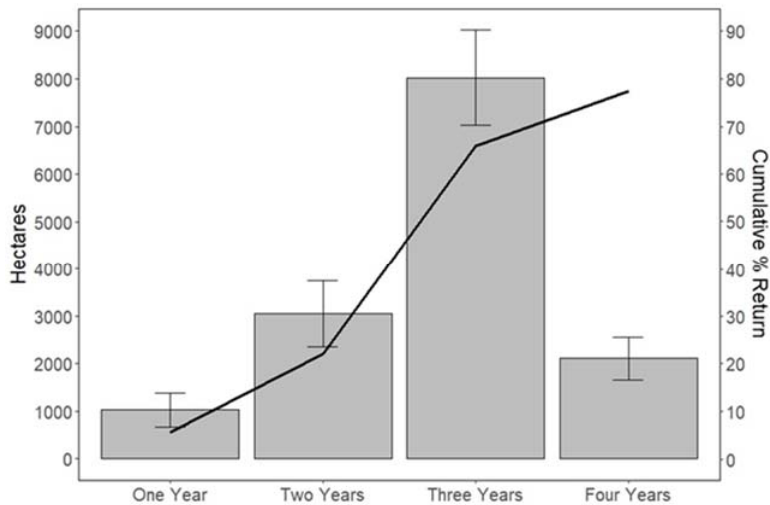
Figure 5. Bar graph represents the average hectares of potato that return after one year (continuous potato), two years (one crop between potato plantings), three years (two crops between), and four years (three crops between), and their respective standard deviations marked by error bars. The line graph represents the cumulative percent of the initial potato crop that has returned to potato. Table 5. Common rotations when rotating with potato after two- (one year off potato), three- (two years off potato), and four-years (three years off potato), mean number of hectares that rotation would occur, and the percent weight compared to all other two-, three-, and four-year potato rotations. Standard deviation indicates the extent of deviation from the mean each rotation has; the CV is the coefficient of variation of annual average variability across all years; the slope, r2 and p -value are from linear regression and indicates the change in hectares planted during the study period, how well this change represents the data, and whether this change is significant. The following abbreviations correspond to the crop grown; C = corn, Sc = sweet corn, Po = potato, B = beans.